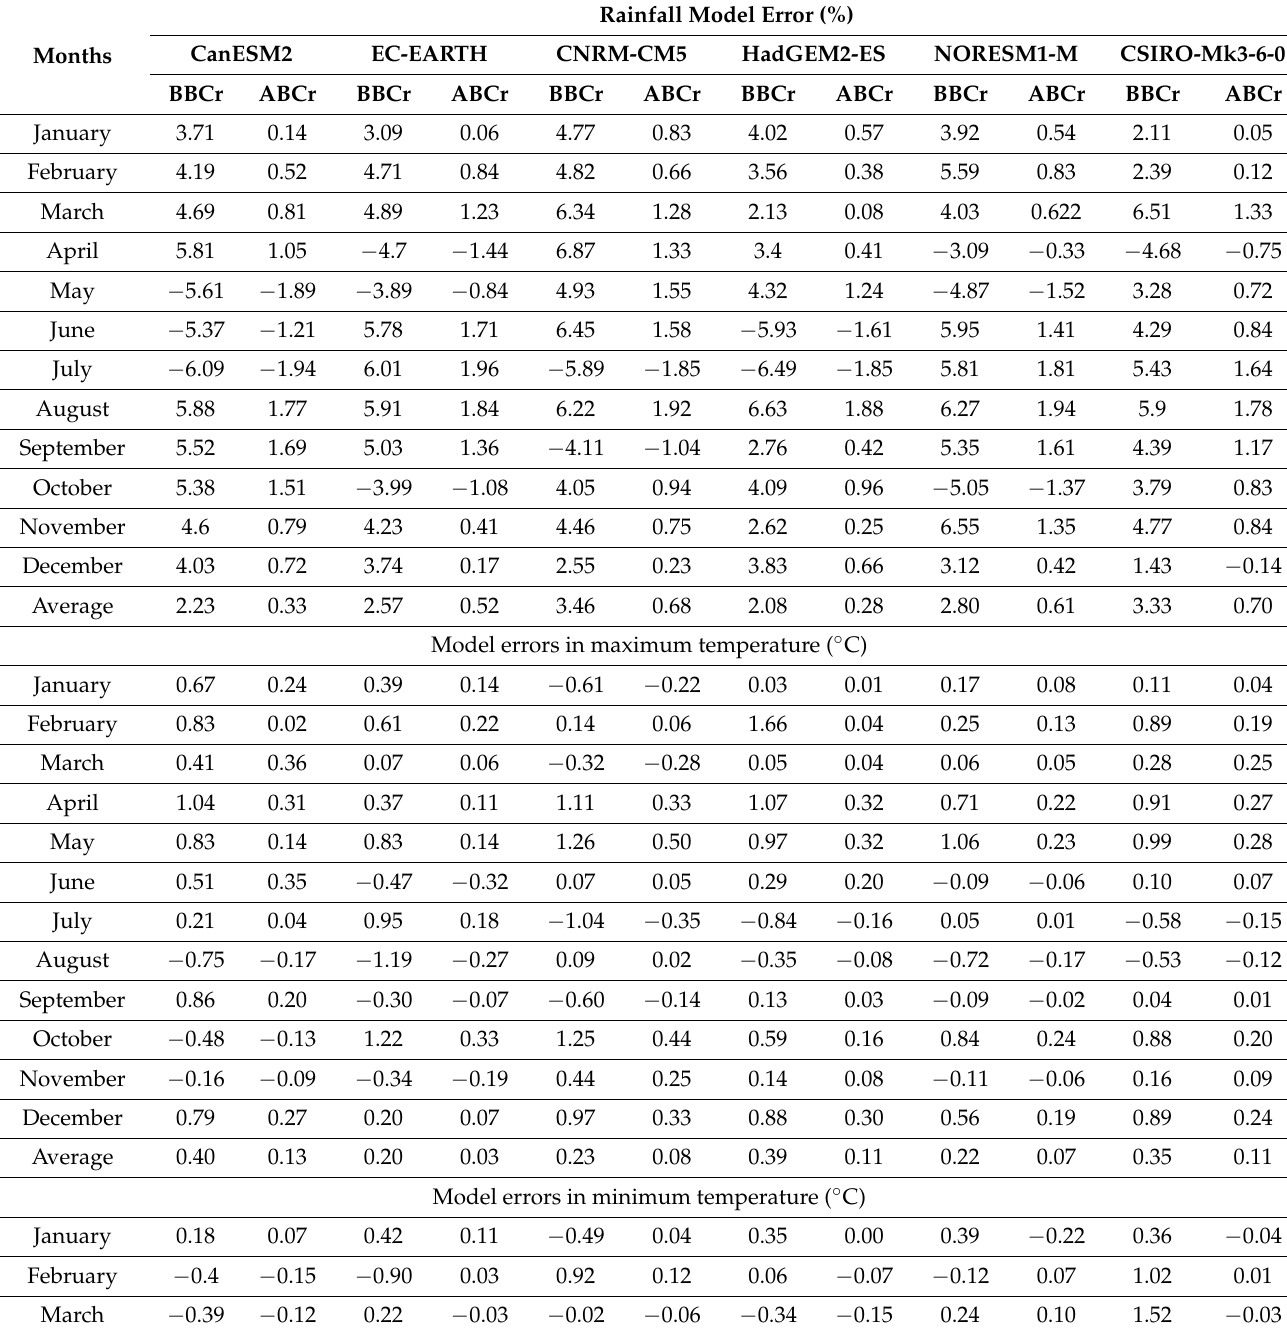
Table 5. Errors of climate models in simulation of climate